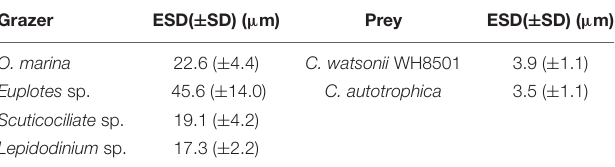
TABLE 1 | Grazers and prey used in this study.